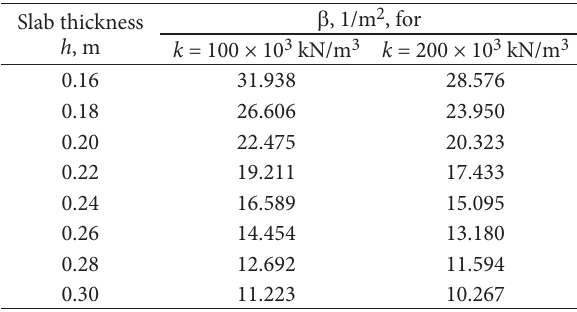
Table 2. Proportionality coefficient β in 1/m 2 between stresses s in kN/m 2 induced in concrete slab and axle load Q in kN for selected concrete slab and load parameters